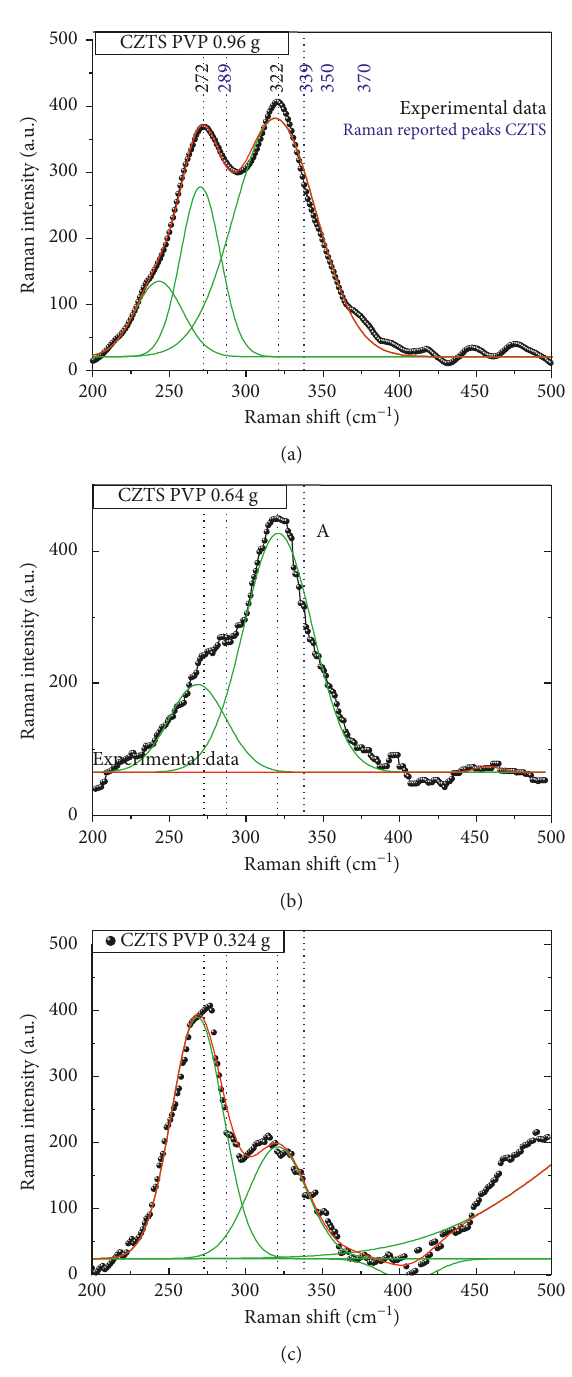
Figure 10: Raman scattering analysis of the CZTS using different PVP contents in their synthesis. Spectra (a) to (c) are ordered from higher to lower content of PVP used during synthesis of the source powders, the PVP content being (a) 0.964g, (b) 0.640g, and (c) 0.324g. Characteristic kesterite Raman peak positions are indicated on top, as well as experimental values resulted from Gaussian